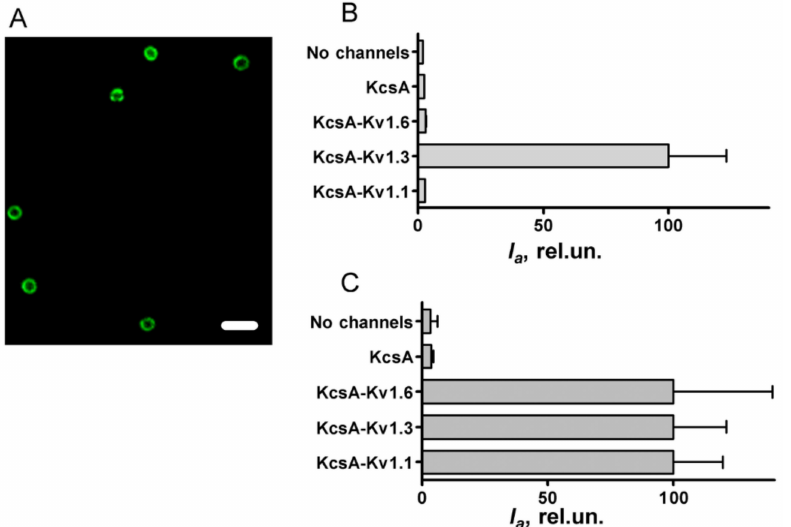
Figure 3. Study of the binding of A-AgTx2 and AgTx2-GFP to hybrid channels KcsA–Kv1.x (x = 1, 3, 6). ( A ) Typical confocal fluorescent image of A-AgTx2 (20 nM) bound to KcsA–Kv1.3 at the surface of spheroplasts. Bar is 2 µ m. ( B ) Average fluorescence intensity I a of A-AgTx2 bound to spheroplasts expressing each of the KcsA–Kv1.x (x = 1, 3, 6) channels and to control spheroplasts prepared from KcsA-expressing or non-transformed cells. Concentration of A-AgTx2 was 20 nM in the case of KcsA–Kv1.3 and 100 nM in other cases. ( C ) Average fluorescence intensity I a of AgTx2-GFP bound to spheroplasts expressing each of the KcsA–Kv1.x (x = 1, 3, 6) channels and to control spheroplasts. Concentration of AgTx2-GFP was 4 nM in the cases of KcsA–Kv1.3 and KcsA–Kv1.6; in other cases,